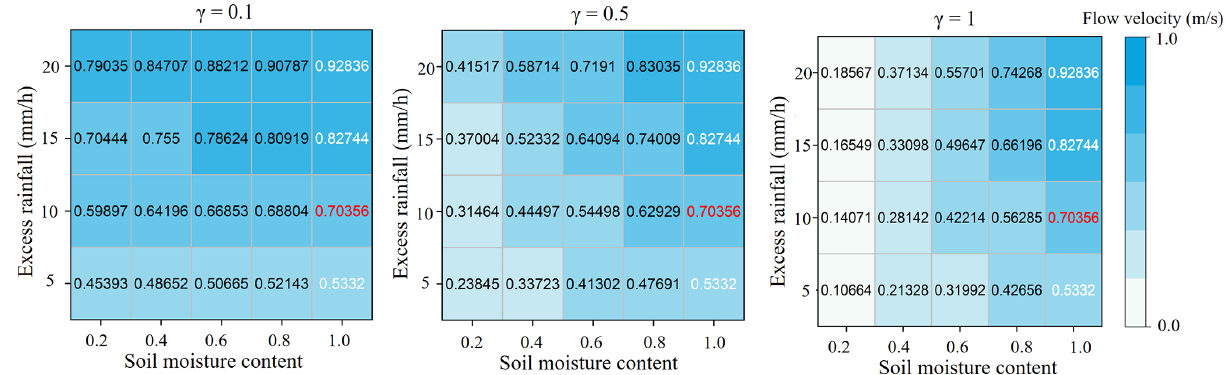
Figure 16. Time-varying flow velocity values corresponding to different parameters.